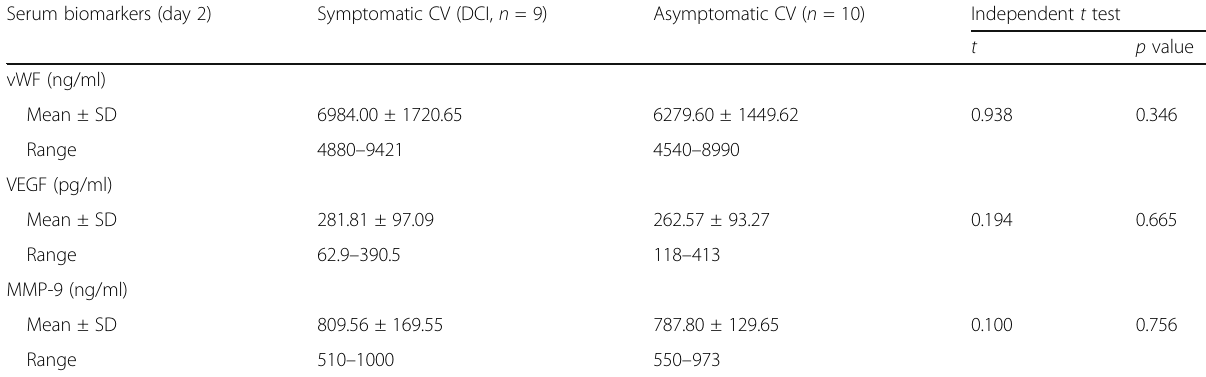
Table 4 Comparison of serum biomarkers between symptomatic CV (DCI) and asymptomatic CV groups (at vasospasm) Serum biomarkers (day 2)